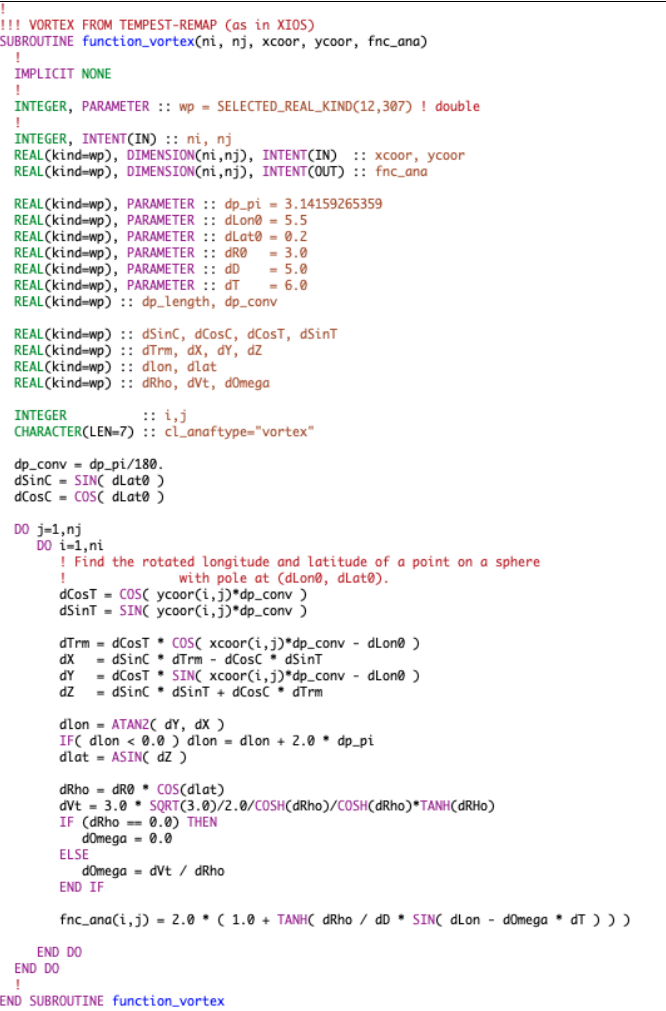
Figure A3. Fortran 90 code defining the vortex analytical function.